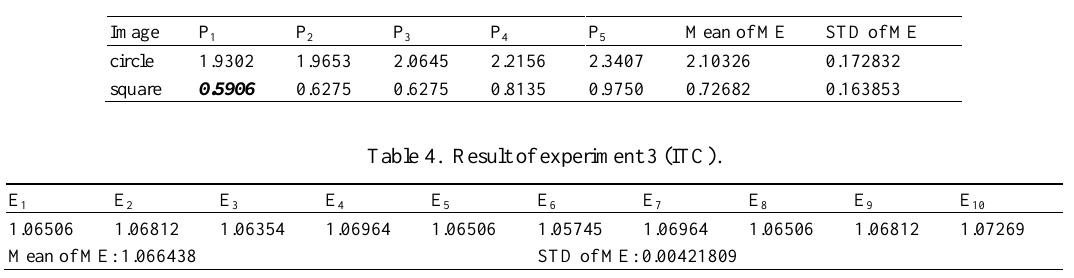
Table 3. Result of of experiment 2 (ITT2).